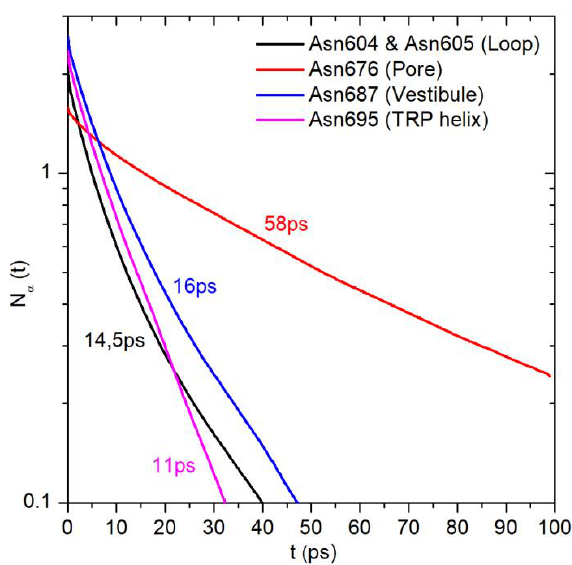
Figure 6. Water survival time correlation functions calculated for the carbonyl oxygen atom of the side chain of asparagine residues (OD1 group) located in different protein regions. The correlation functions were averaged over four identical protein subunits and over four MD trajectories. Corresponding values of τ res are shown near the curves.